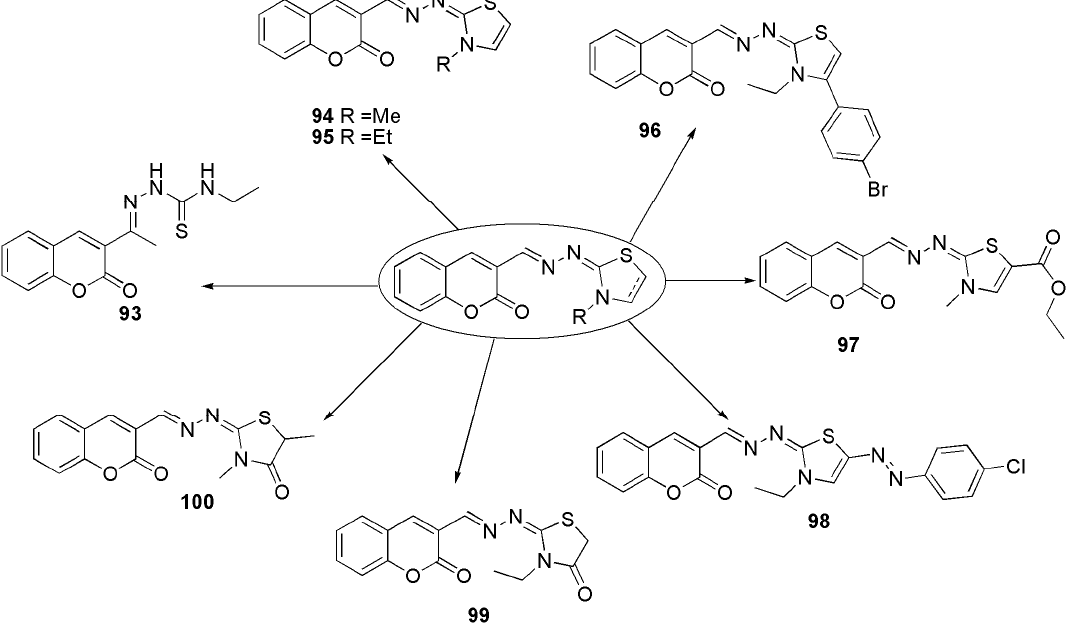
Figure 34. Anti-inflammatory coumarin derivatives.